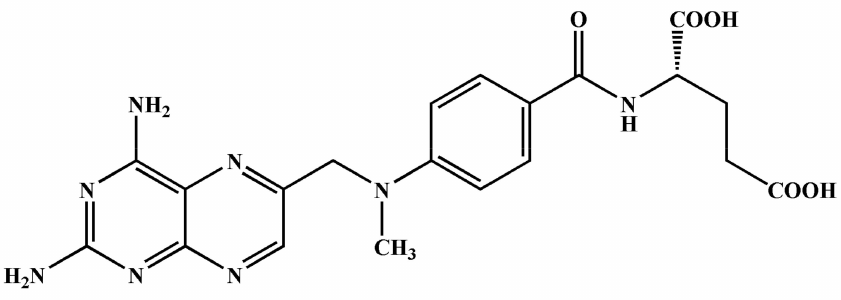
Figure 5. Chemical structure of methotrexate (MTX).